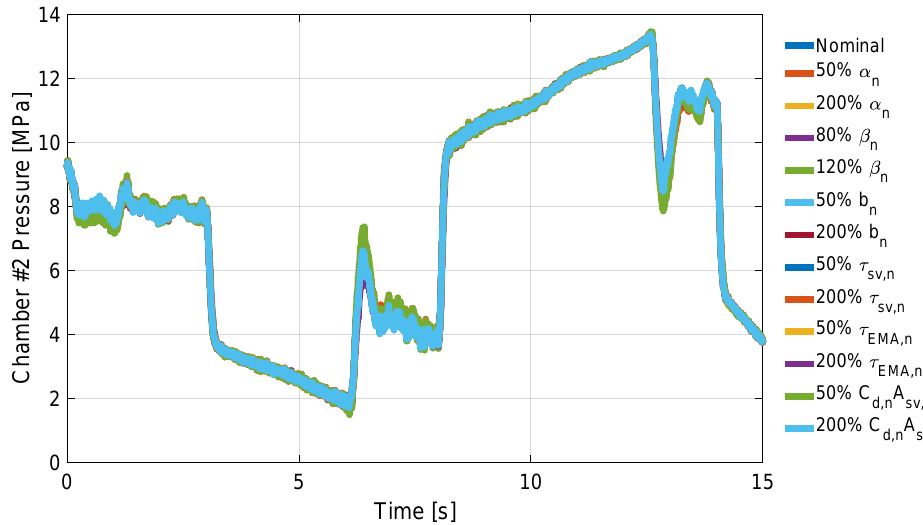
Figure 16. Simulation #2: Chamber #2